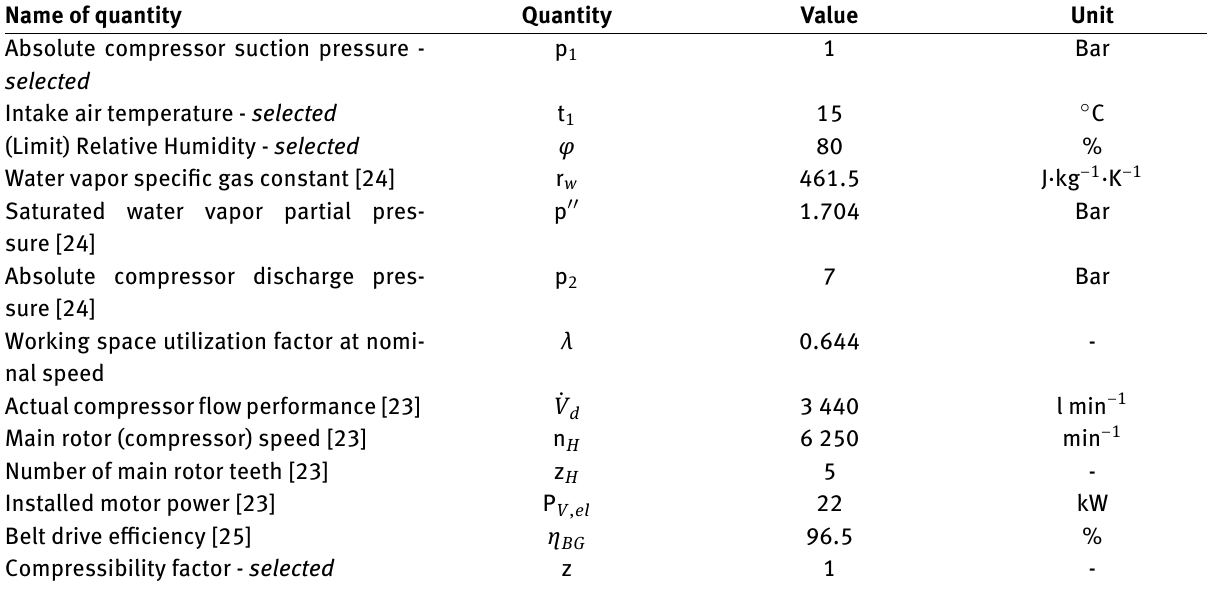
Table 1: Input values of ideal mathematical model